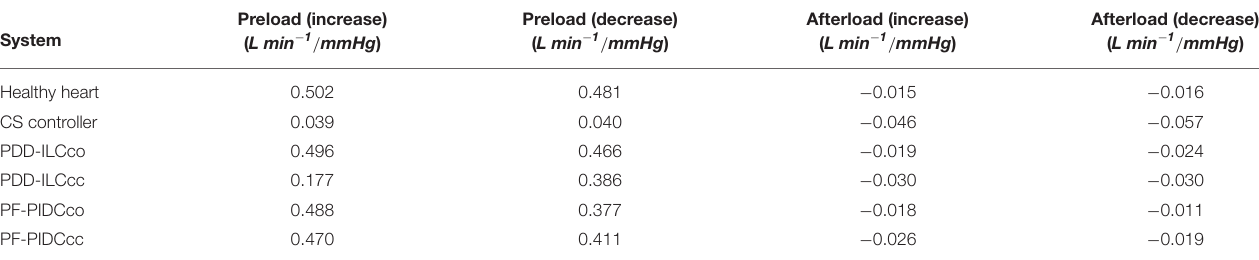
TABLE 2 | Preload and afterload sensitivity of the healthy heart (HH), the constant speed (CS) controller, the PDD-ILC, and the PF-PIDC calculated in experiments Exp1 and